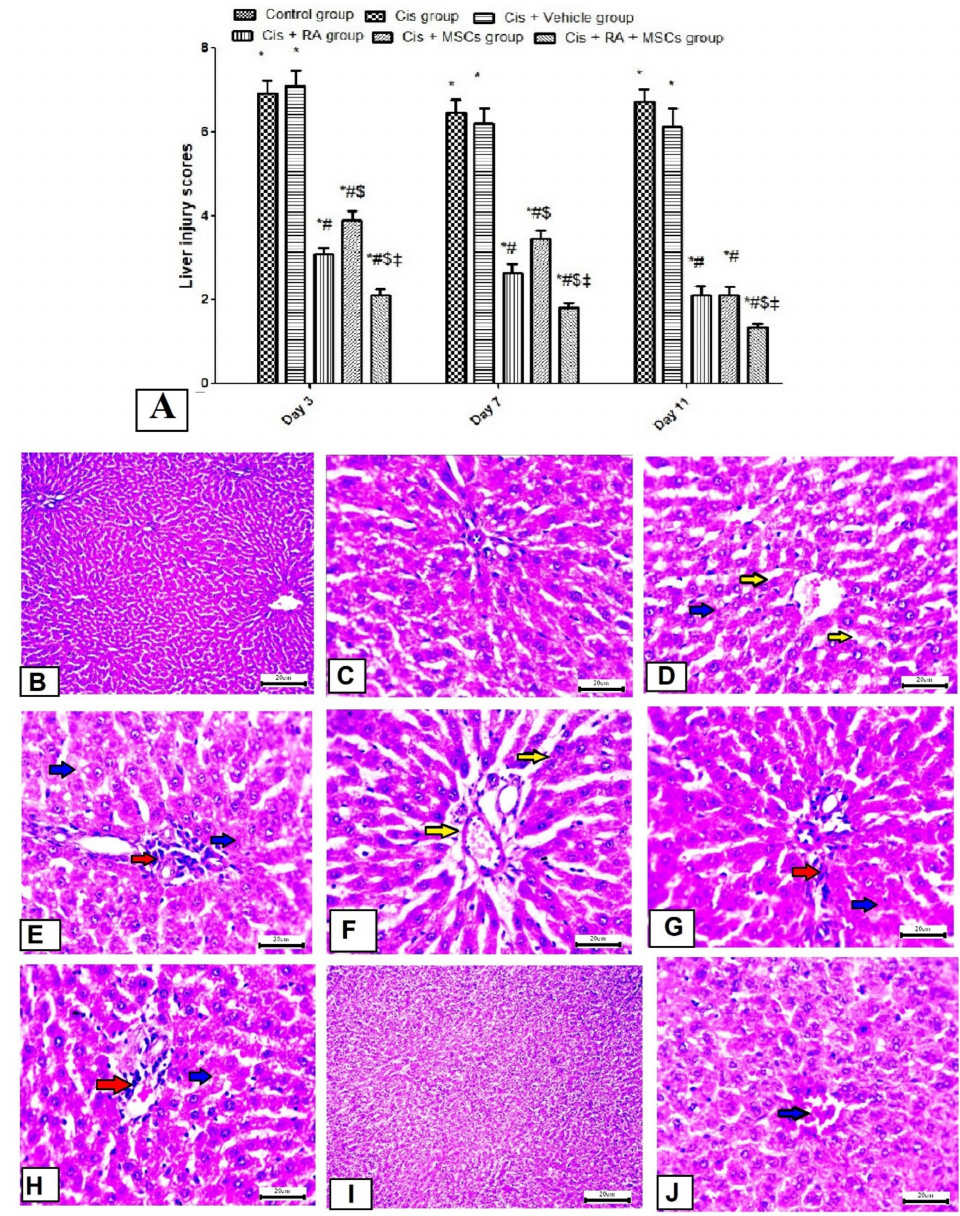
Figure 5. Histopathological examination of liver specimens. The score of liver damage at different time intervals (3 days, 7 days and 11 days) showed significant rise in damage score in Cis and vehicle groups and significant attenuation in all treated groups (Cis + RA, Cis + BM-MSCs and Cis + RA + BM-MSCs groups) ( A ). Microscopic images from control group show normal radial arrangement of hepatic cords around central veins with normal portal areas and sinusoids at 11 days from start of experiment (( B ) 100 × and ( C ) 400 × ). Liver sections from Cis group show disrupted hepatic cords, interstitial edema (yellow arrow) and inflammation (red arrows), diffuse hydropic degeneration in hepatocytes (blue arrows) and occluded sinusoids (( D , E ) 400 × ). Moreover, liver specimens from vehicle group shows the same morphological findings (( F ), 400 × ). Liver specimens from Cis + BM-MSCs group (( G ) 400 × ), Cis + RA (( H ) 400 × ) and Cis + RA + BM-MSCs (( I ) 100 × and ( J ) 400 × ) at 11 days show improved liver pictures with milder hydropic degeneration in hepatocytes detected in some sections than in untreated Cis group after 11 days. * Significant vs. control group, # significant vs. Cis group, $ significant vs. Cis + MSCs group and ‡ significant vs. RA